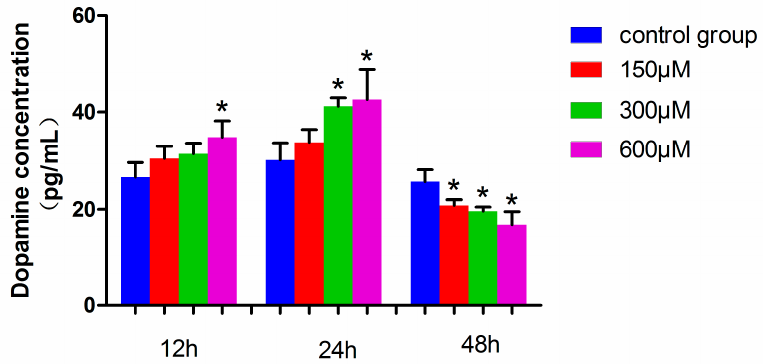
Figure 7. Dopamine levels in MN9D cells exposed to simazine for 12, 24, 48 h. Bars indicate mean ± S.E.M. * statistically significant difference compared with the control, * p < 0.05, 3 repeated experiments for each group, n = 3.